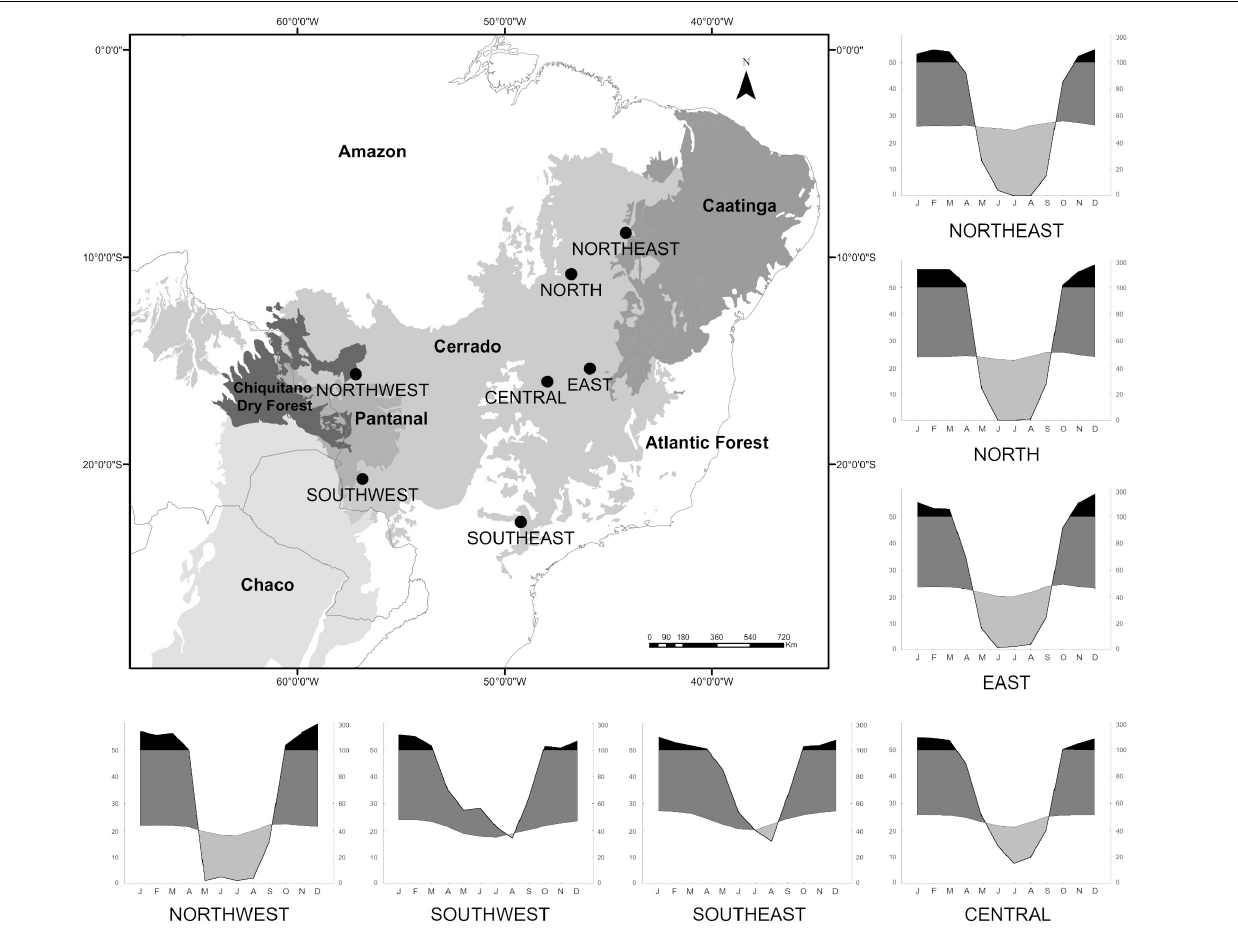
FIGURE 1 | The seven localities surveyed across the Cerrado biome. Limits of the Cerrado and neighboring biomes in gray tones based on the ecoregion approach of Dinerstein et al. (2017). Climatic diagrams showing variations in annual temperature (left vertical axis) and rainfall regime (right vertical axis) within each locality surveyed in the Cerrado. In black, periods of rainfall above 100 mm; in dark gray, periods of rainfall above the temperature line, both periods usually associated with the rainy season; in light gray, periods of water deficiency, associated with the dry season. CENTRAL = Área Alfa Cerrado Reserve, EAST = Grande Sertão Veredas